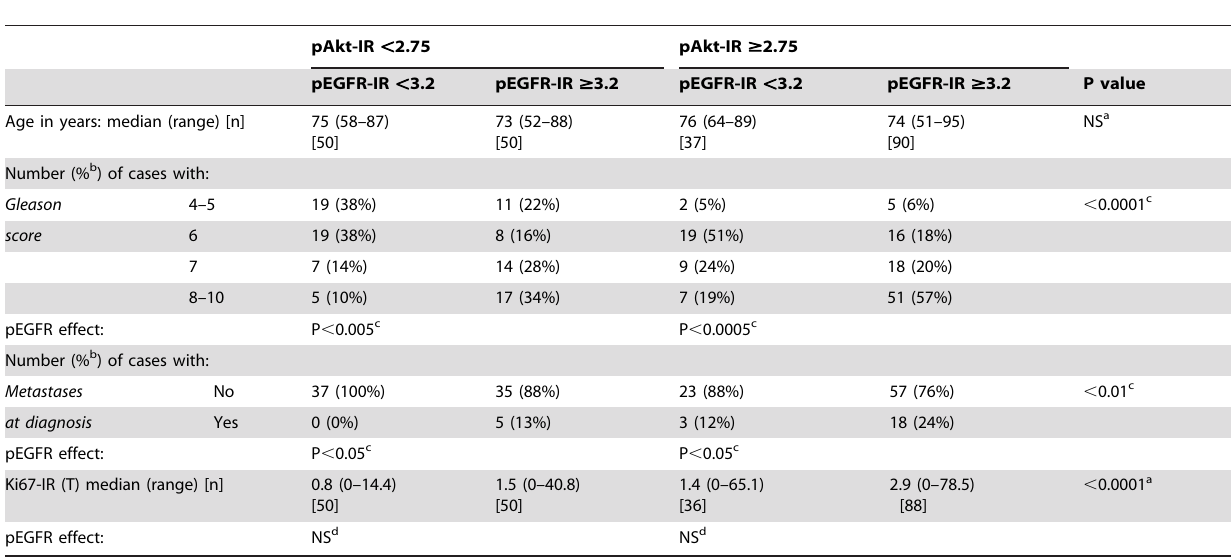
Table 3. Age, Gleason scores, incidence of metastases at diagnosis and tumour Ki67-IR at diagnosis for the cases divided on the basis of tumour pAkt-IR and pEGFR-IR